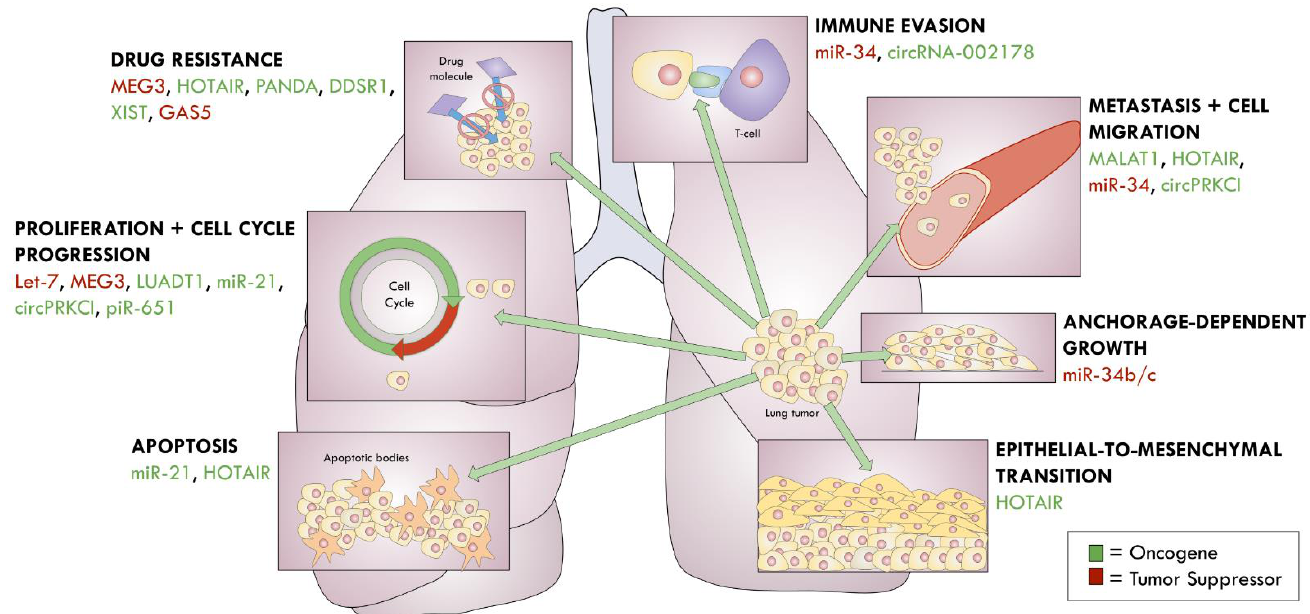
Figure 3. ncRNAs in lung